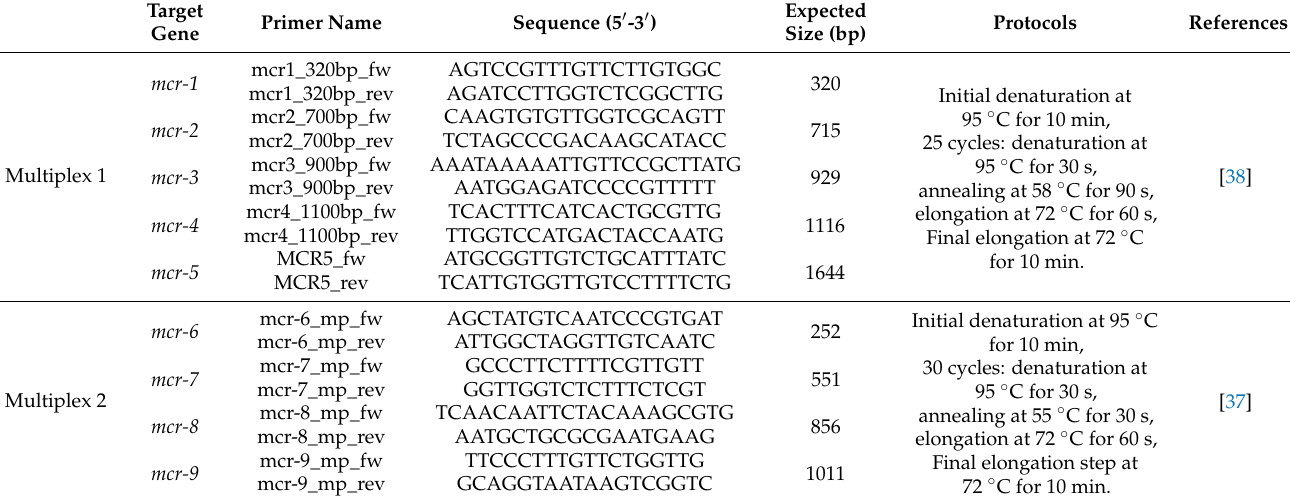
Table 7. Primers and protocols employed in PCR